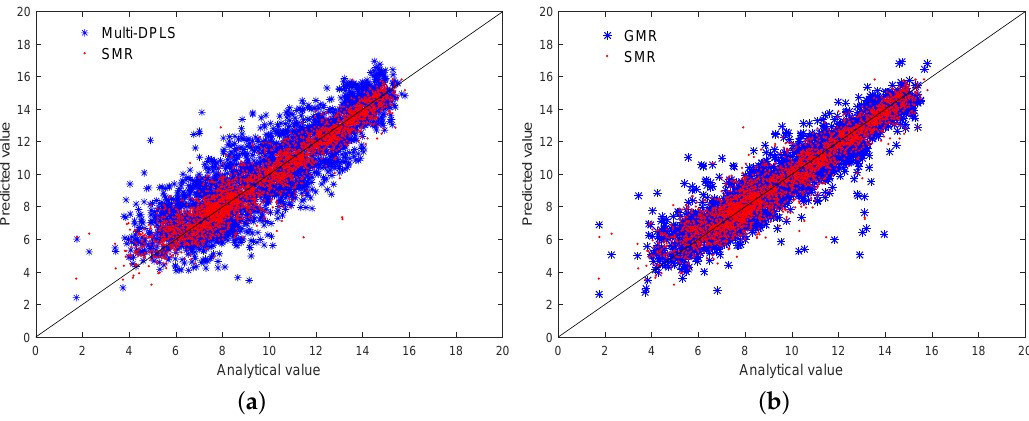
Figure 13. Scatter plot comparisons for estimating the concentration of O 2 : ( a ) Multi-DPLS and SMR; ( b ) GMR and